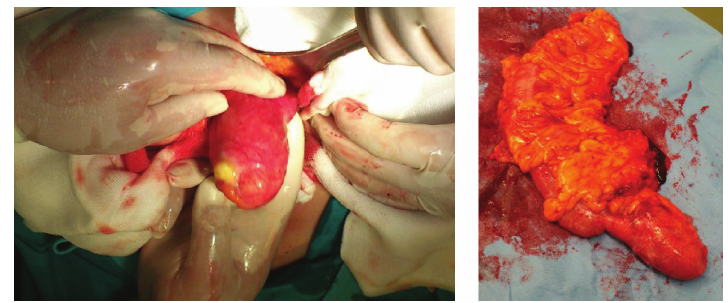
Figure 2: Intraoperative